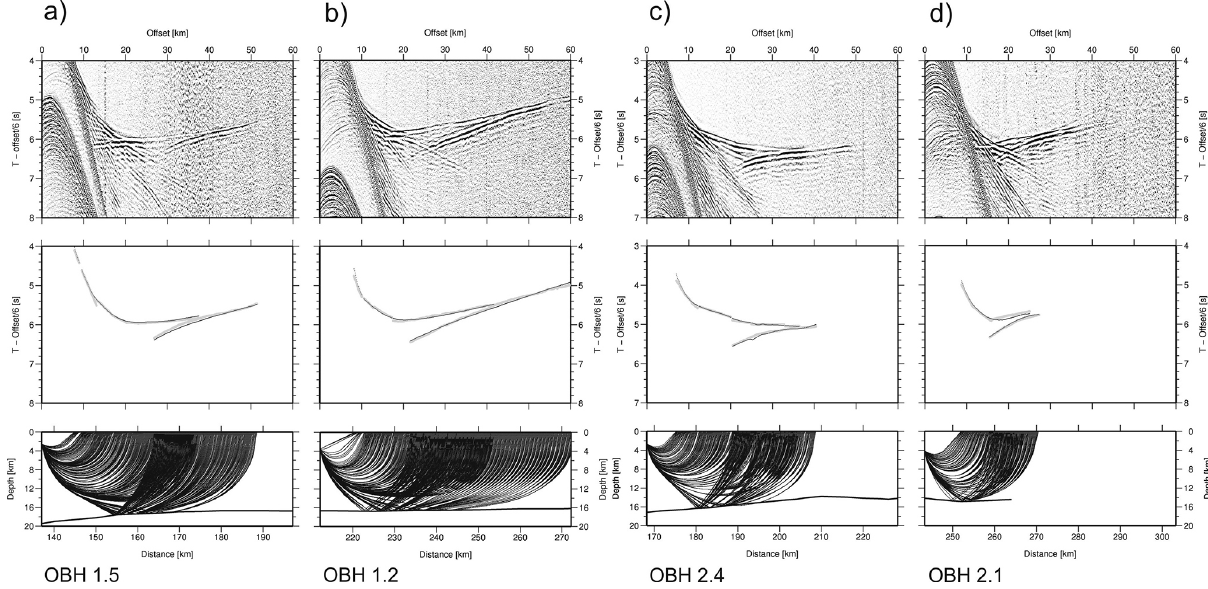
Figure 2. Data example for ocean-bottom hydrophones (OBHs) from line 1 ( a : OBH1.5; b OBH1.2) and line 3 ( c : OBH2.4; d OBH2.1). The reduction velocity is 6kms − 1 . Upper panels: seismic sections for OBHs. Middle panels: the middle panels represent the picked travel times as gray circles and the calculated travel times as black dots for the final model. Lower panels: the lower panels show the ray coverage for the stations.